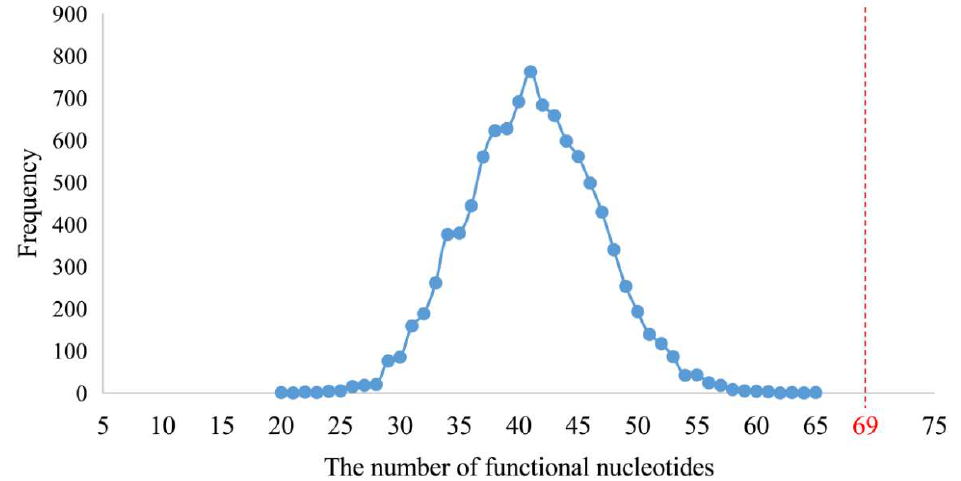
Figure 6. Number of randomly sampled functional nucleotide sites from the three rRNAs. The numbers of functional nucleotide sites contained in the randomly sampled 805 nucleotide sites are shown in blue. In total, 230 functional nucleotide sites of contemporary rRNAs were summed up. Sixty-nine of them were located in the 75 short fragments (marked in red).